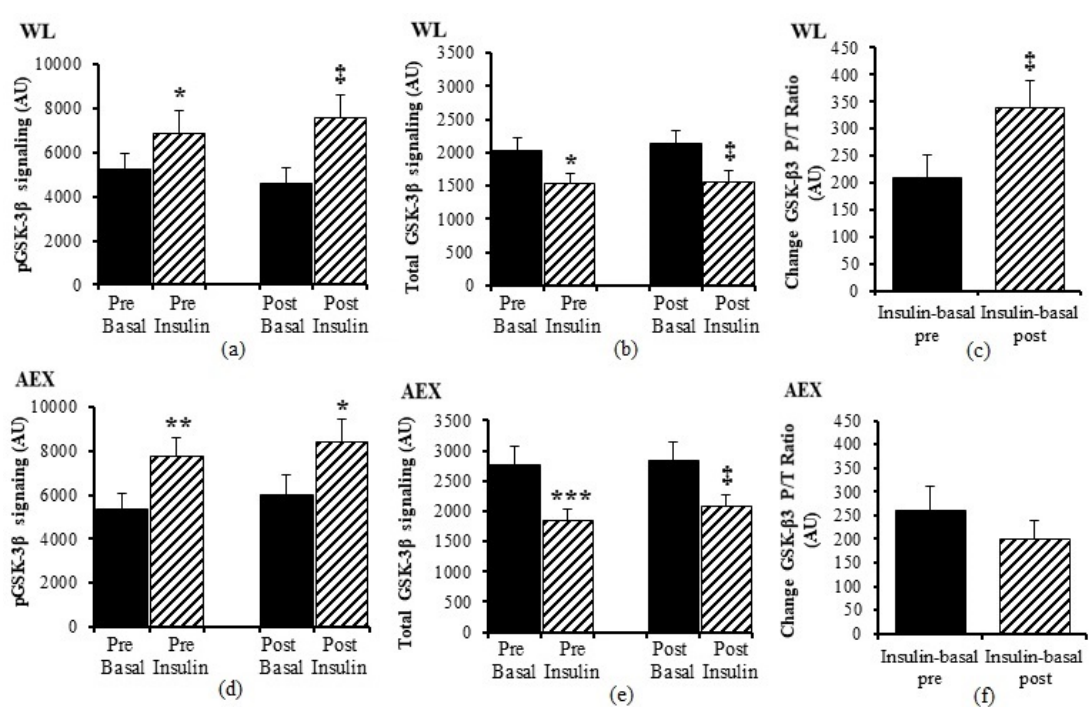
Figure 2. Skeletal muscle GSK-3 β phosphorylation and total protein expression level at basal (solid) and insulin-stimulated (striped) pre and post of WL ( a , b ) and AEX ( d , e ). Change GSK3ß (Insulin-basal) at pre and post of WL ( c ) and AEC ( f ). Paired t -tests between pre basal vs. pre insulin, post basal vs. post insulin, and pre vs. post basal analyses within WL